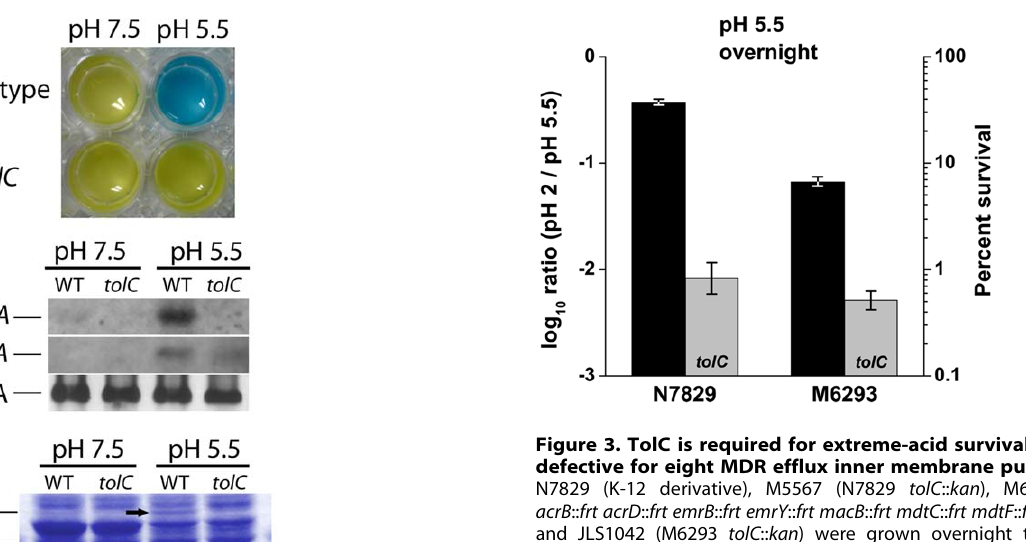
GadA and GadB proteins were absent in the tolC strain at pH 5.5 (Fig. 2C). Without TolC, no gadA or gadB expression could be detected.